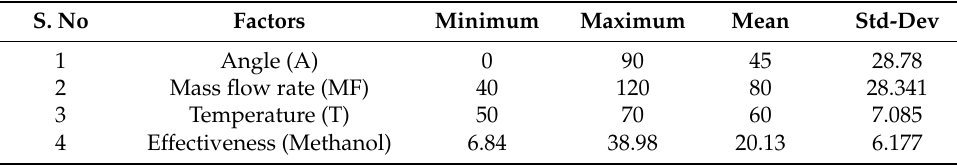
Table 2. Parametric levels used in experiment.